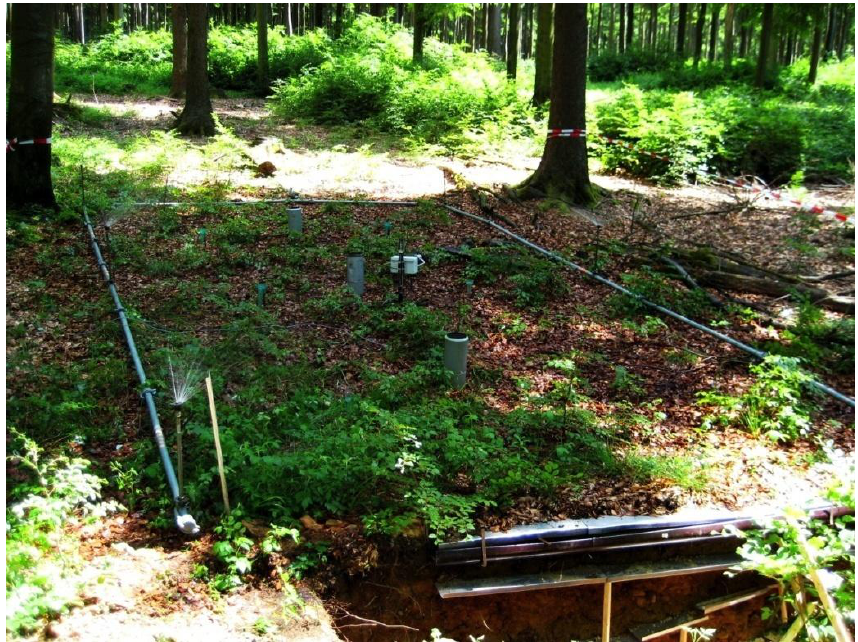
Figure 3. Rainfall simulator based on the idea of Karl & Toldrian [24] at the Holzbach test site with soil pit and collector plates visible in the